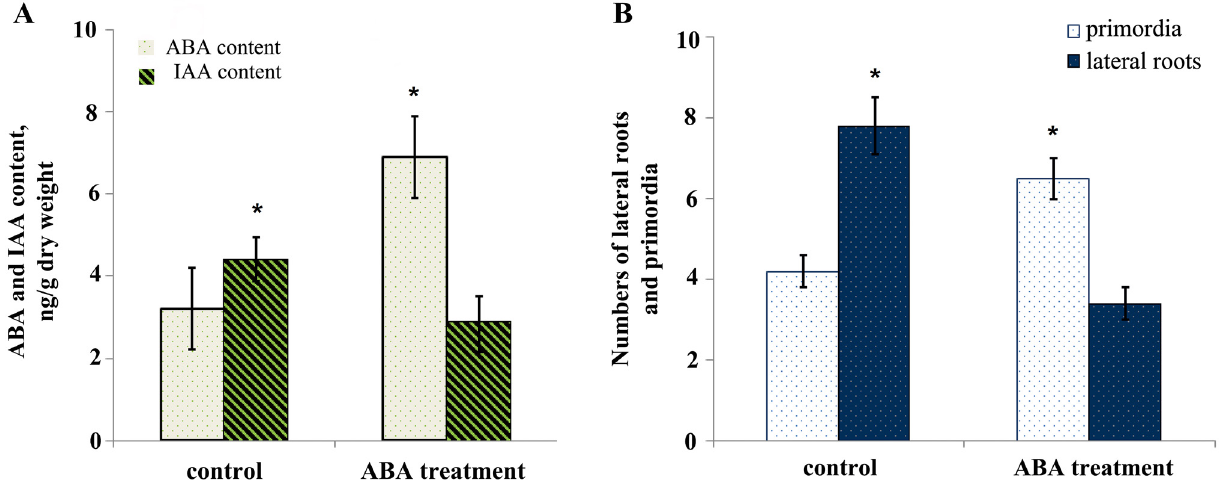
Figure 7. ABA and IAA content in roots ( A ) and numbers of primordia and lateral roots ( B ) in ABA-deficient Az34 barley plants grown under control conditions or exposed for 3 days to 0.1 mg/L ABA. Significantly different means from control are marked with asterisk. Values are means ± S.E. ( n = 25) ( p ≤ 0.05, t-test).